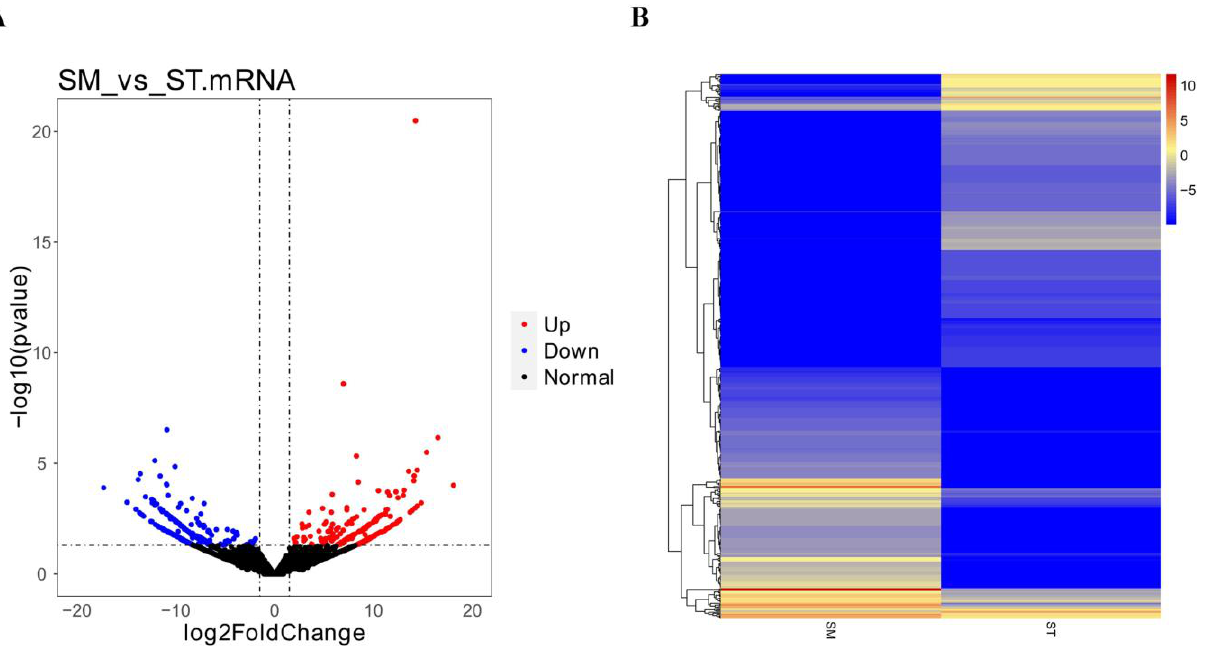
Figure 4. Significant difference analysis of mRNAs. ( A ) Volcano plot of identified mRNAs between SM vs. ST, where blue and red represent down-regulated and up-regulated, respectively. ( B ) Heat maps revealing the differentially expressed (DE) mRNA in hair follicle between SM vs. ST.